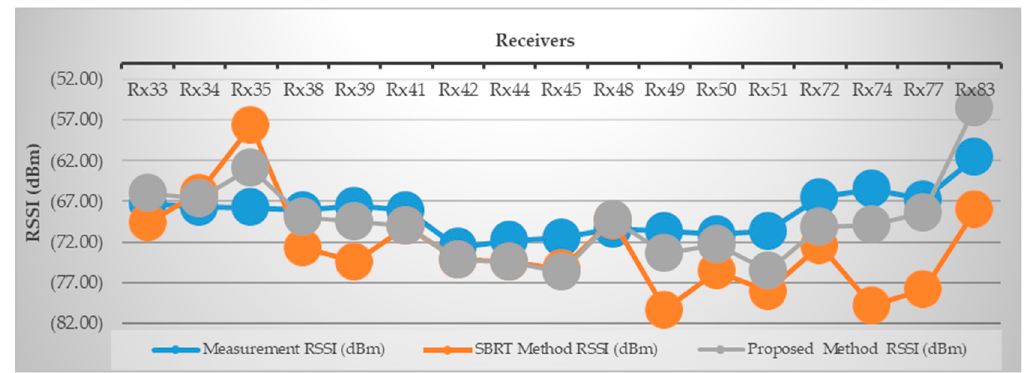
Figure 10. The measurement and SBRT proposed methods RSSI comparison graph.